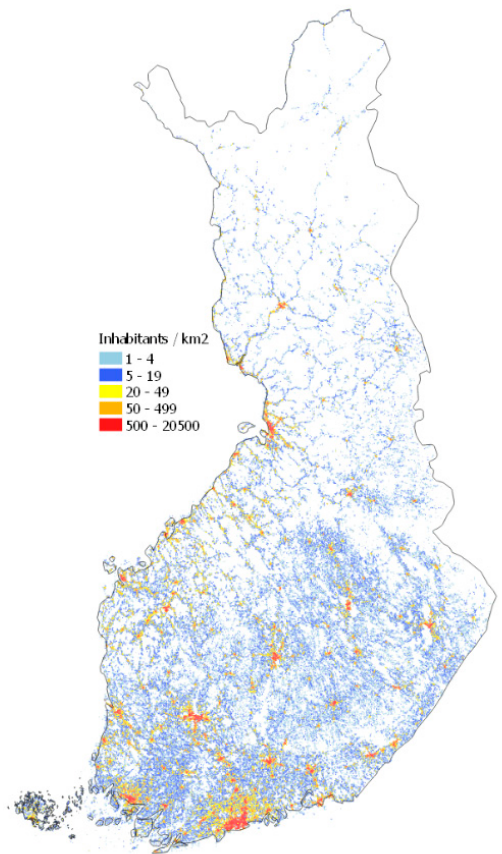
Figure 1. Population density in Finland at 1 km resolution.